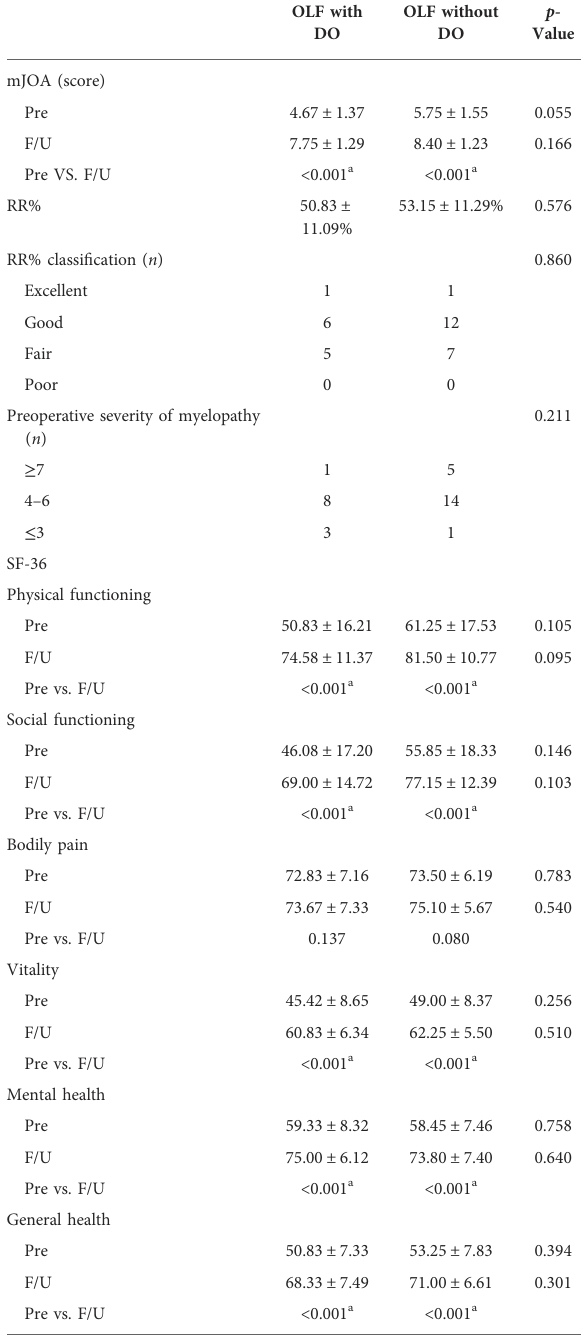
TABLE 3 Comparison of postoperative neurological recovery and health related quality of life.